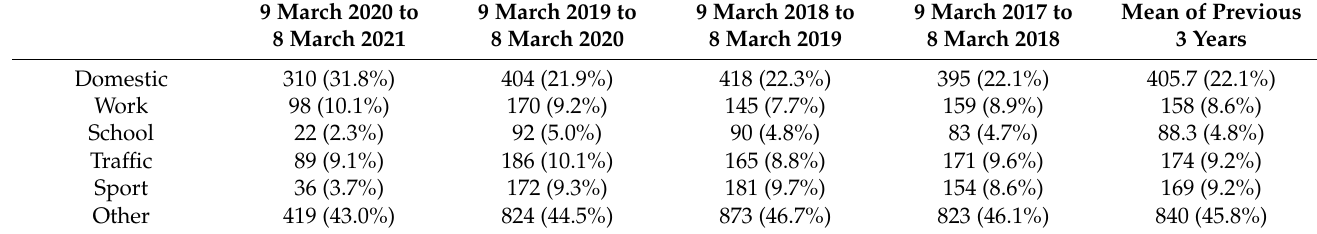
Table 2. Cause/location of accidents.